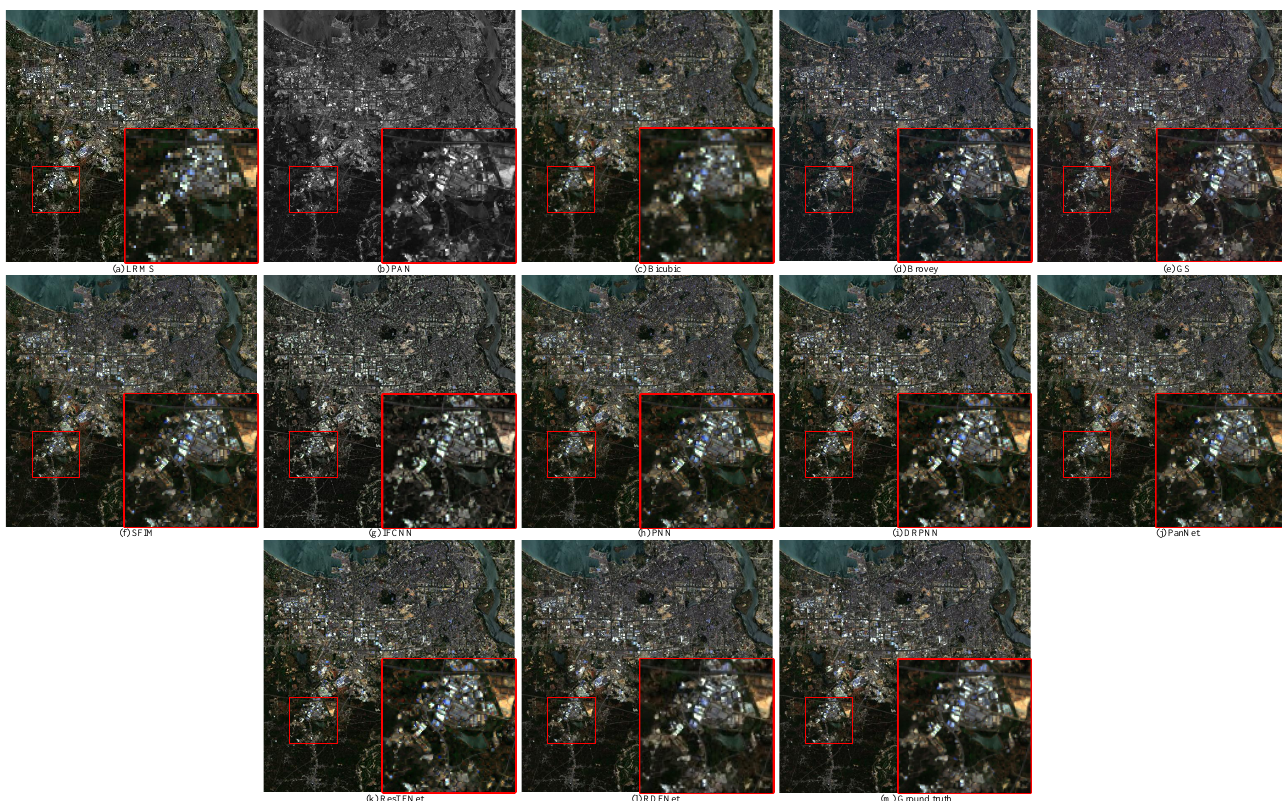
Figure 11. Subjective visual comparison between RDFNet and the current mainstream fusion methods for the testing dataset fusion results of Landsat-8 with reduced resolution. ( a ) LRMS; ( b ) PAN; ( c ) Bicubic; ( d ) Brovey; ( e ) GS; ( f ) SFIM; ( g ) IFCNN; ( h ) PNN; ( i ) DRPNN; ( j ) PanNet; ( k ) ResTFNet; ( l ) RDFNet (ours); ( m ) ground